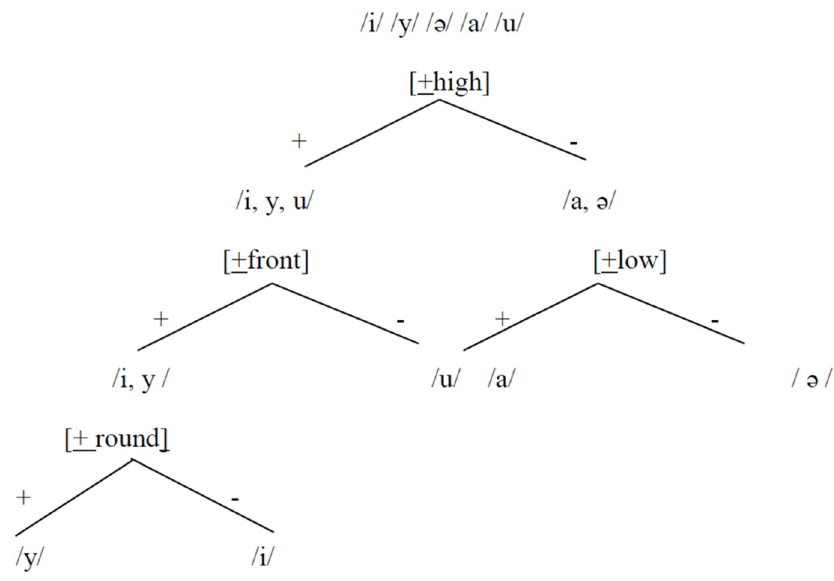
Figure 15. The contrastive hierarchy of Mandarin vowels.